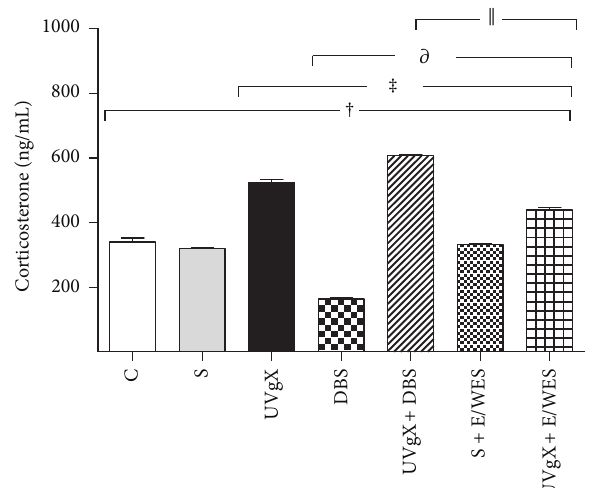
Figure 3: Effect of unilateral vagotomy and deep brain stimulation of hypothalamic nucleus on corticosterone levels in Wistar